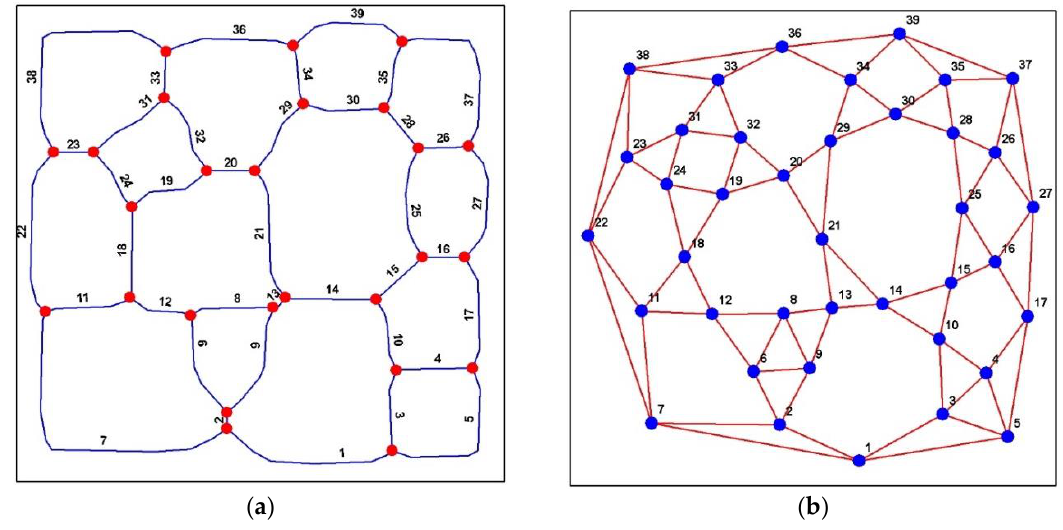
Figure 4. Skeleton (39 blue lines) and junctions (26 red points) on the left ( a ) and its dual graph on the right ( b ): blue points means 39 skeleton lines and 78 red lines means the connections.